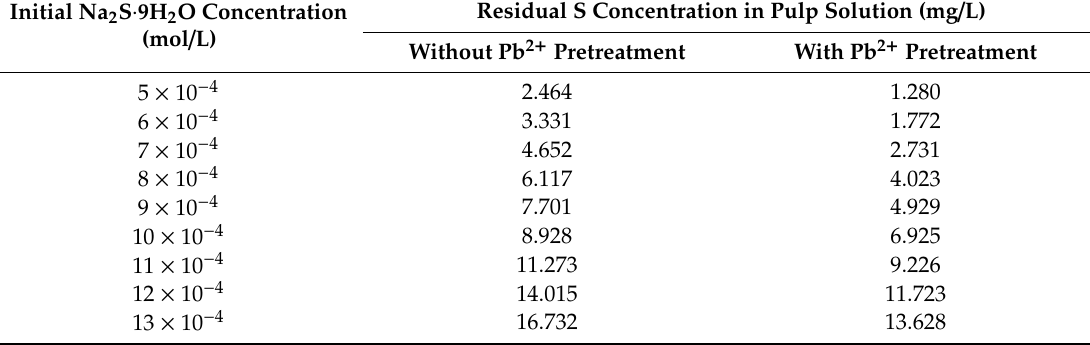
Table 1. Residual S concentration in the solution with and without Pb 2 + pretreatment for di ff erent initial Na 2 S · 9H 2 O